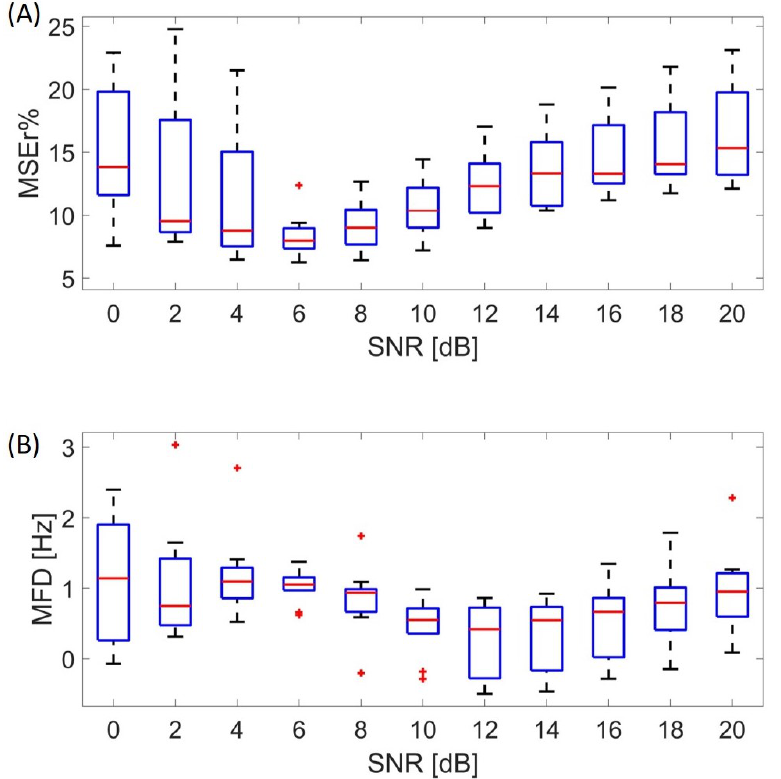
Figure 6. Performance of the SVD algorithm at different values of the SNR in terms of the mean squared error ( A ) and mean frequency difference ( B ). The present results were obtained on the whole signal, including the EMG from the voluntary contraction and the signal at rest. MFD, mean frequency